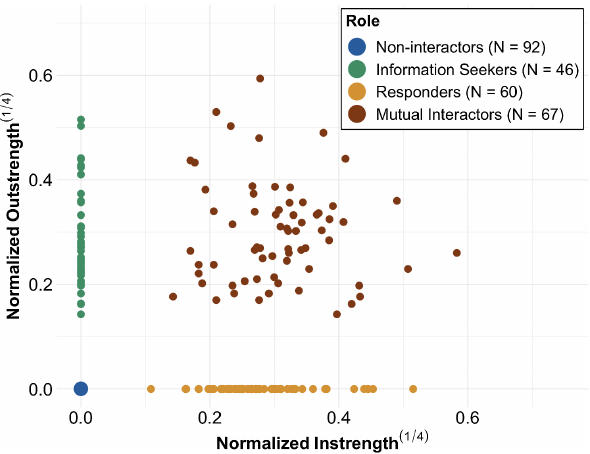
FIG. 4. Transformed scatterplot with a point for each observed lab group based on normalized outstrength and normalized instrength. Colors of each point indicate the social role assigned to the group by our